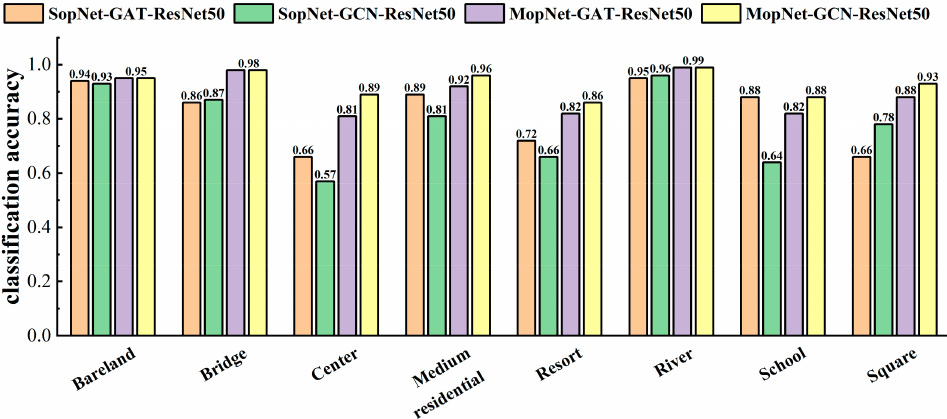
Figure 10. Classification accuracies calculated by MopNet and SopNet on some typical classes of the AID dataset under the training ratio of